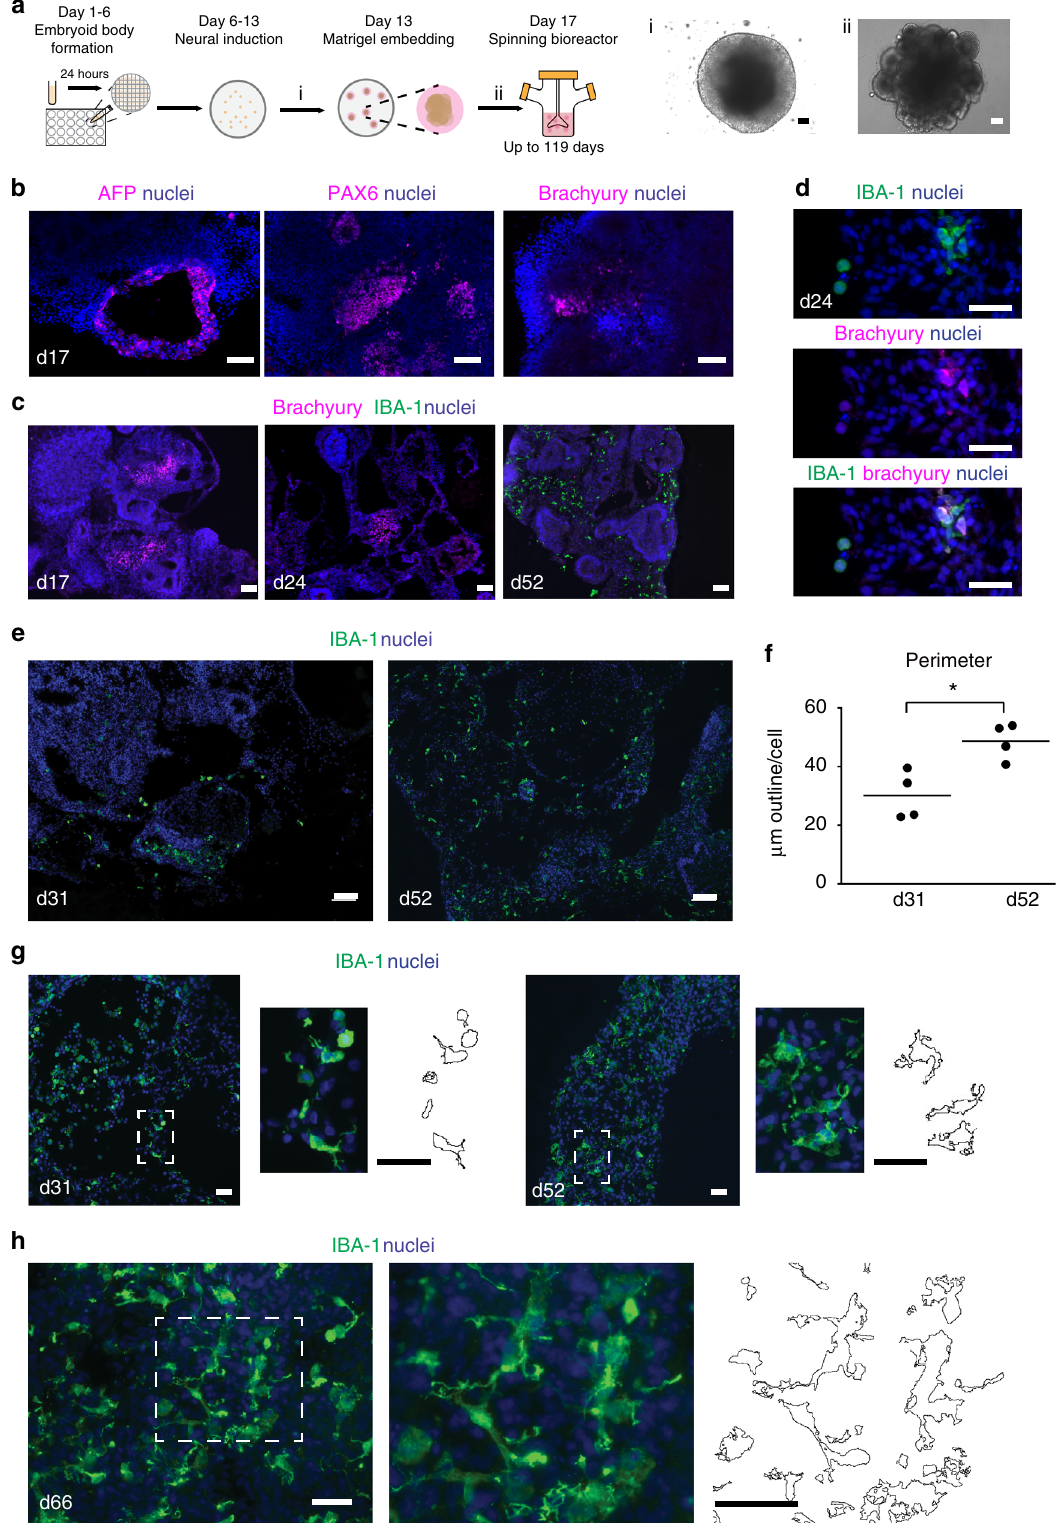
RNAseq transcriptomic pro fi ling of oMG isolated from three independent organoid donors (oMG1, 3 and 5) at day 38 and day 52. Inter-donor variability was small (oMG ρ = 0.91 ± 0.001) when examined with Spearman correlation coef fi cients